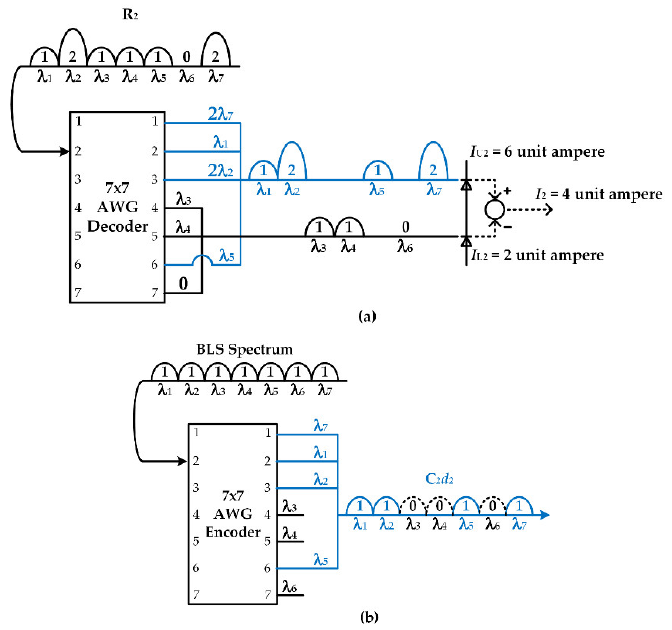
Figure 6. Spectral distributions of M-sequence code C 2 in the process of ( a ) decoding and ( b ) encoding, based on AWG structure.